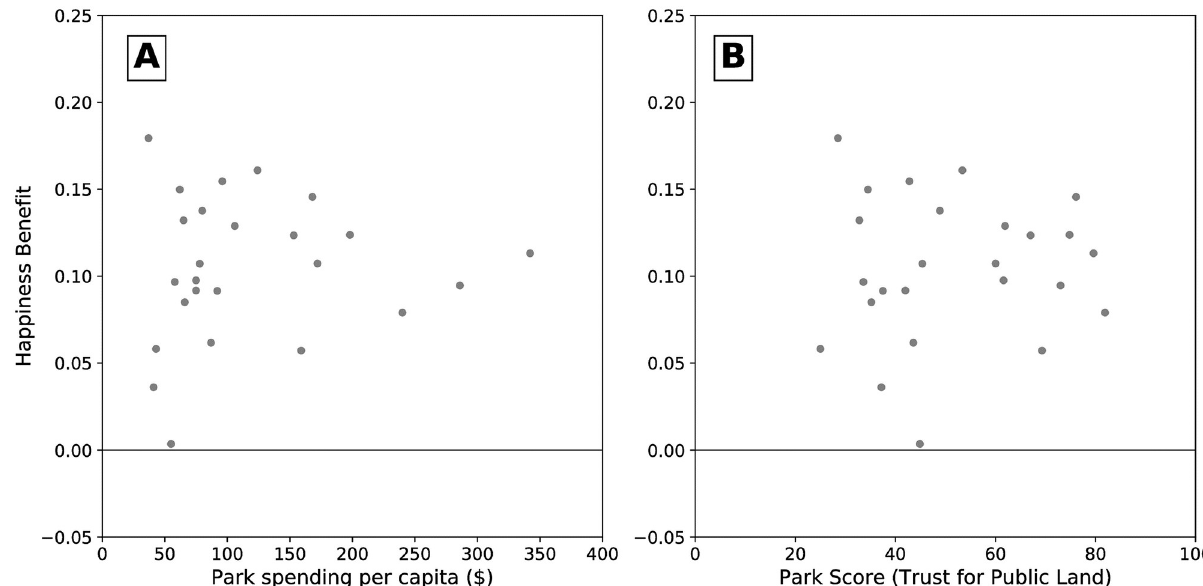
Fig 3. Park analysis and happiness benefit. A . Park spending per capita vs mean happiness benefit by city. Park spending per capita is from Trust for Public Land (TPL) data. B . ParkScore 1 vs happiness benefit. The TPL calculates ParkScore 1 annually from measures of park acreage, access, investment, and amenities, and is scaled to a maximum score of 100. The happiness benefit was not strongly correlated with per capita spending (Spearman’s ρ = 0.14) or ParkScore 1 (Spearman’s ρ = 0.03).